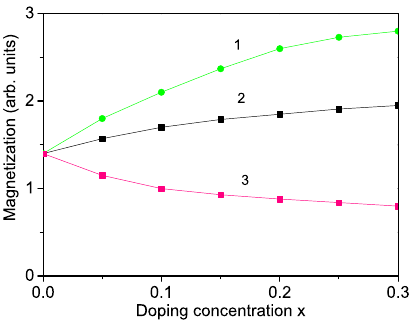
= 0 . 8 J ′ and N = 10 shells. s b